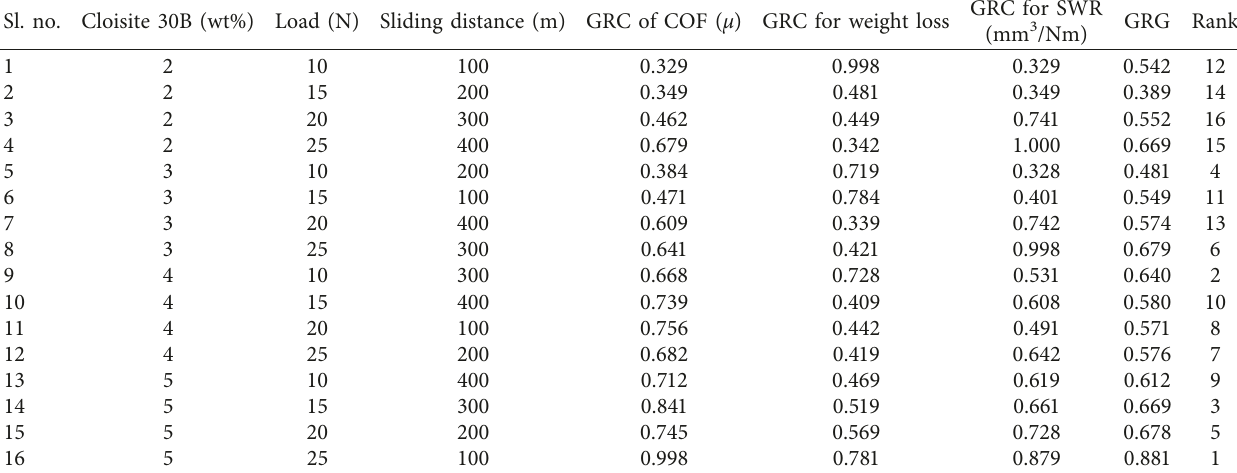
Table 4: The grey relation coefficient and grey relational grade for abrasive wear responses.